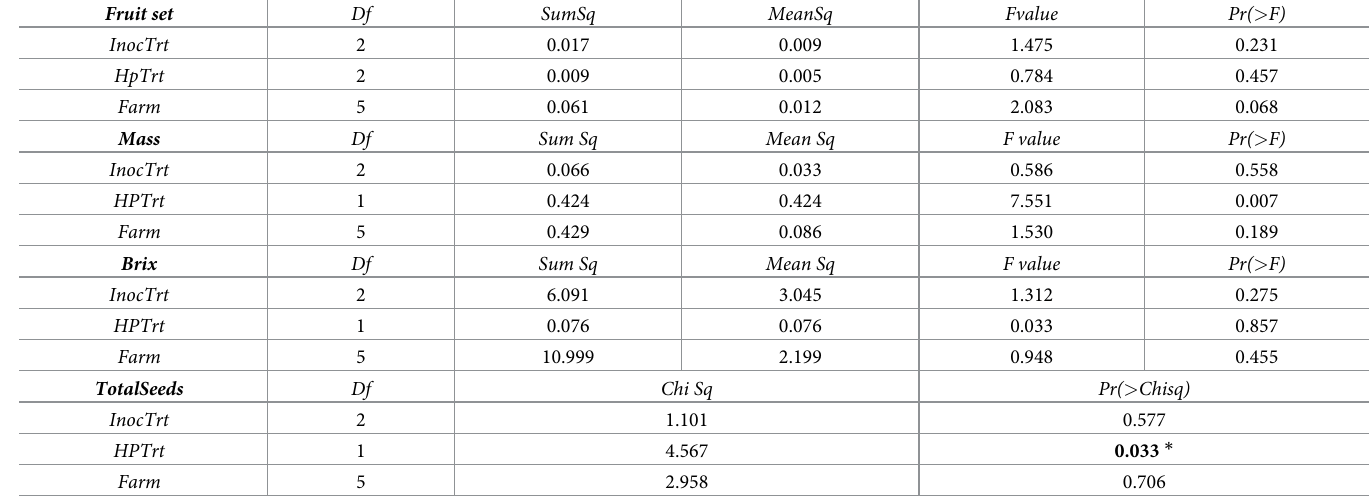
Table 1. Effects of inoculation treatment (InocTrt), hand pollination treatment (HPTrt), and farm on fruit set, individual berry mass, sugar content, and total seeds per berry. Fruit